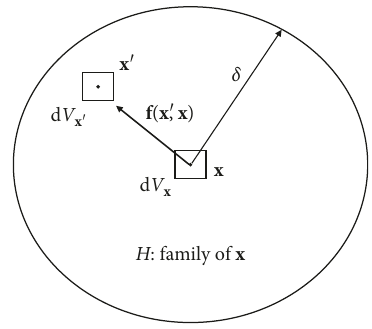
Figure 1: Peridynamic horizon of node x .